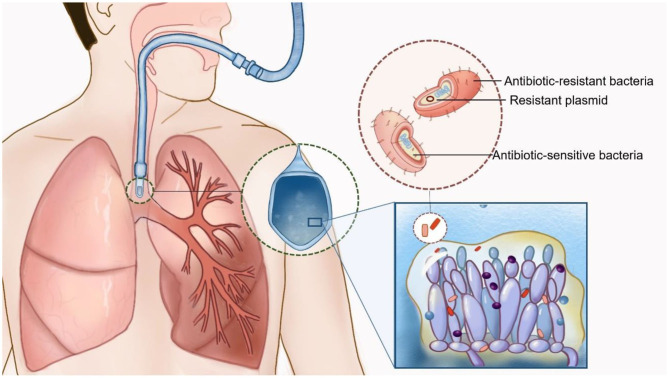
Interaction of Candida spp. and bacteria in patients with mechanical ventilation. Candida biofilms are easily found on the respiratory tract or the surfaces of endotracheal tubes. Biofilms not only have a protective effect on Candida but also have a strong adsorption effect on co-existing bacteria. Multidrug-resistant bacteria could be isolated by the transmission of drug-resistant plasmid transmission and polymicrobial biofilm formation (Drawn by Chunhui Xu).